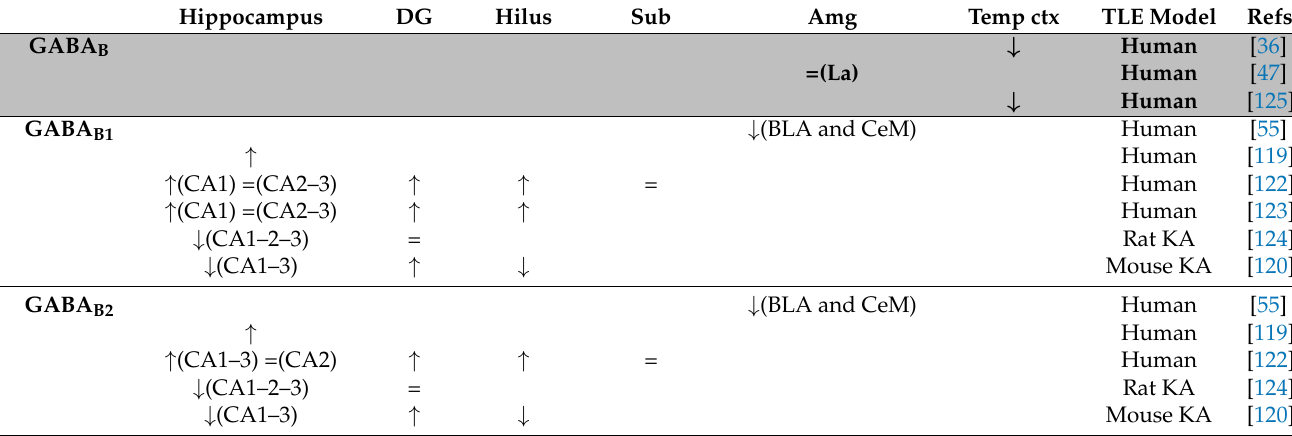
Table 4. Alterations of neuronal GABAergic metabotropic